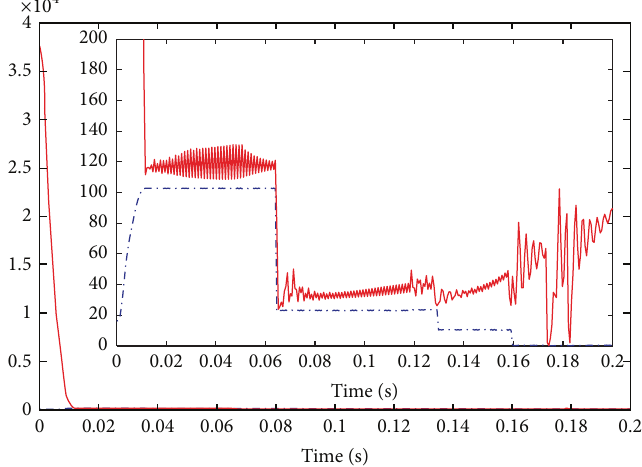
Figure 8: Plots of ‖Φ(𝑡)‖ (blue line) and ‖∑ 4096 𝑖=1 ∑ 2 𝑙=1 ℎ 𝑙 (𝑡)ℎ 𝑙 (𝑡)Δ𝑌 𝑖𝑙 𝐸(𝑡)‖ (red